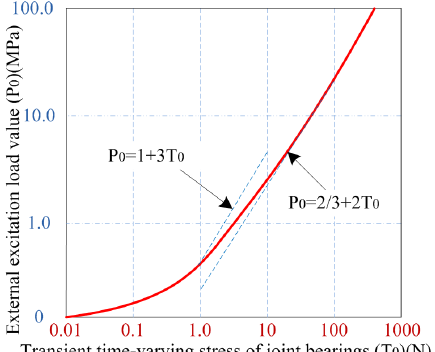
Figure 12. Correlation time-varying curve between two parameters P 0 and T 0 .